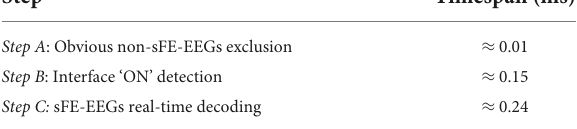
with the sFE-paradigm is shown in Figure 19 , along with the deviation by FlexPendant. From bottom to top, the first axis is the timeline, and the second axis is a counter which represents the processing of n th 100 ms EEGs. The five boxes in the lower area illustrate the algorithm results along the timeline step-by-step, and the four boxes in the upper area illustrate the systematic movement of the AUBO-i5 robotic arm. The x , y , and z axes for the robotic arm system of AUBO-i5 are consistent with Figure 4A , and the timelines for all axes and all boxes remain